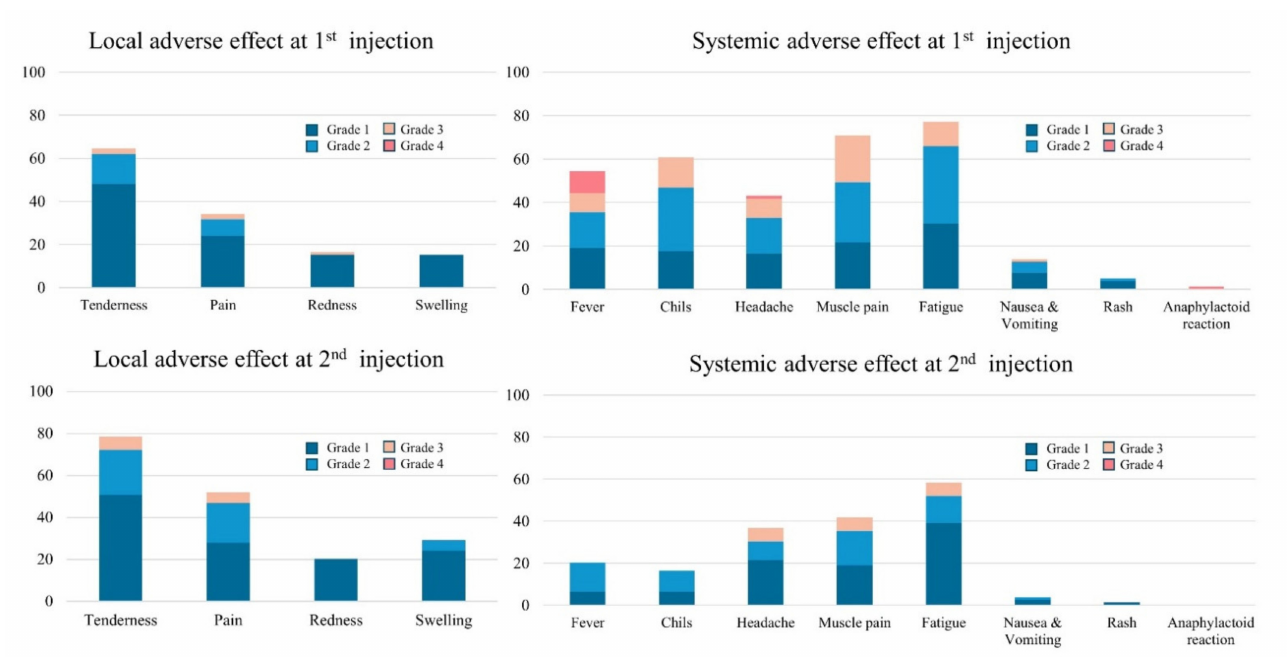
Figure 3. Systemic and local adverse events during first and second injections according to the grade of